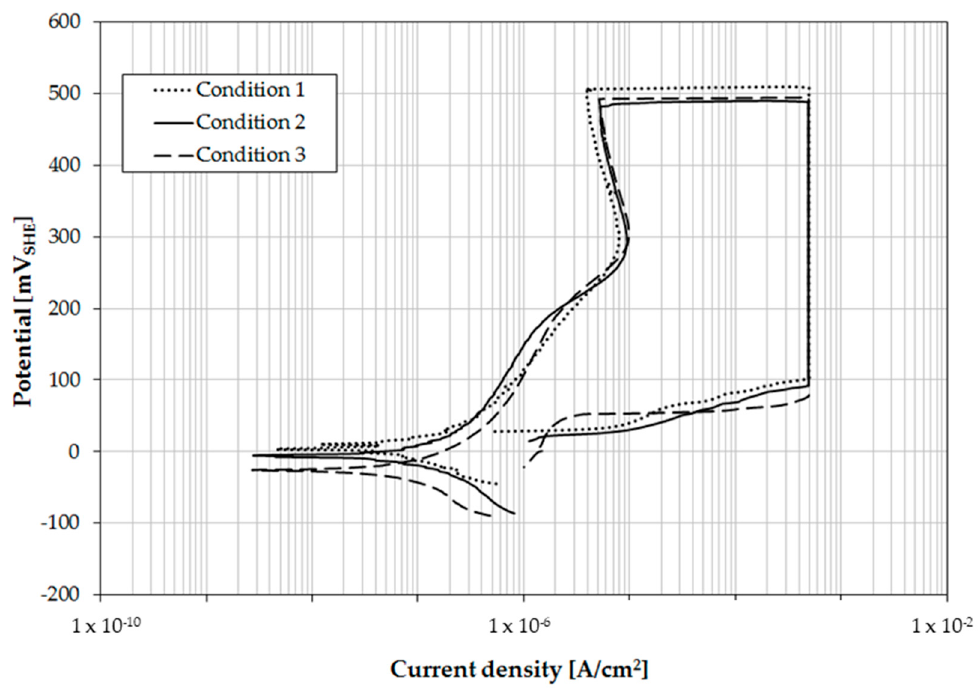
Figure 2. Typical cyclic polarization curves of alloy 718 in 2.25 mol/L Cl − -sol. of pH 9 at 125 °C. Table 2. Electrochemical parameters of alloy 718 in 2.25 mol/L Cl − -sol. of pH 9 at 125 °C.